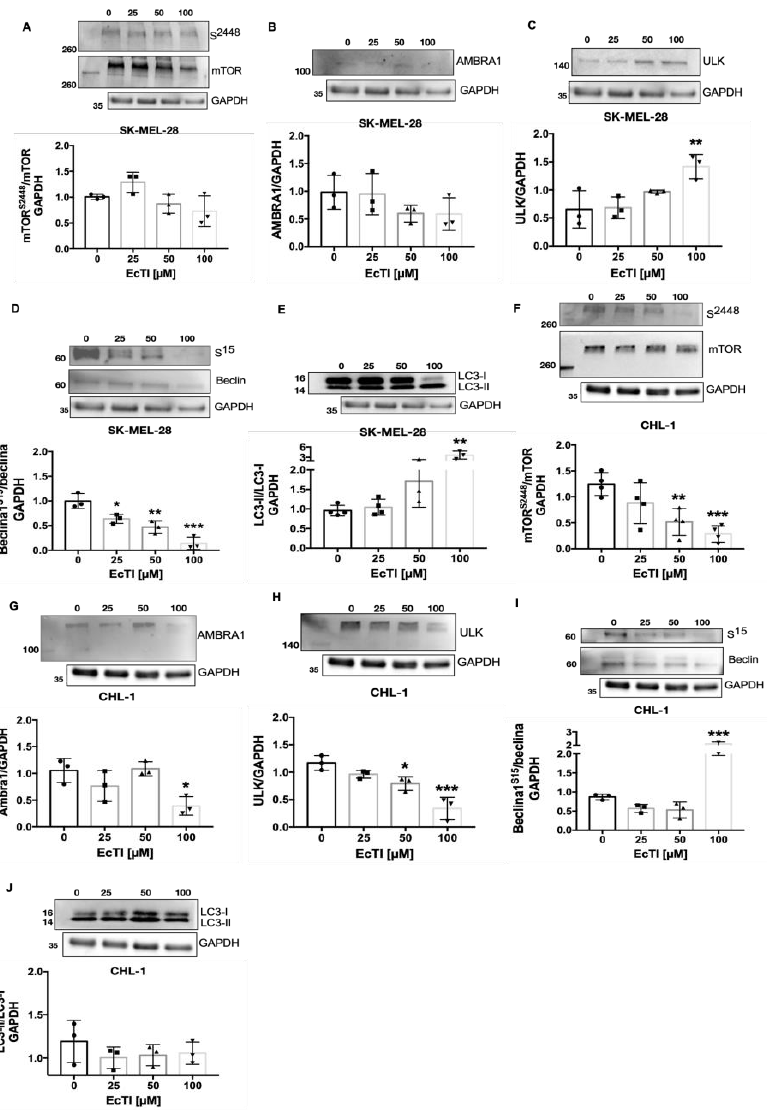
Figure 6. Autophagy-related proteins. The action of EcTI on different proteins related to the autophagic process is depicted in panels ( A – J ). EcTI affected autophagy protein levels. Although no